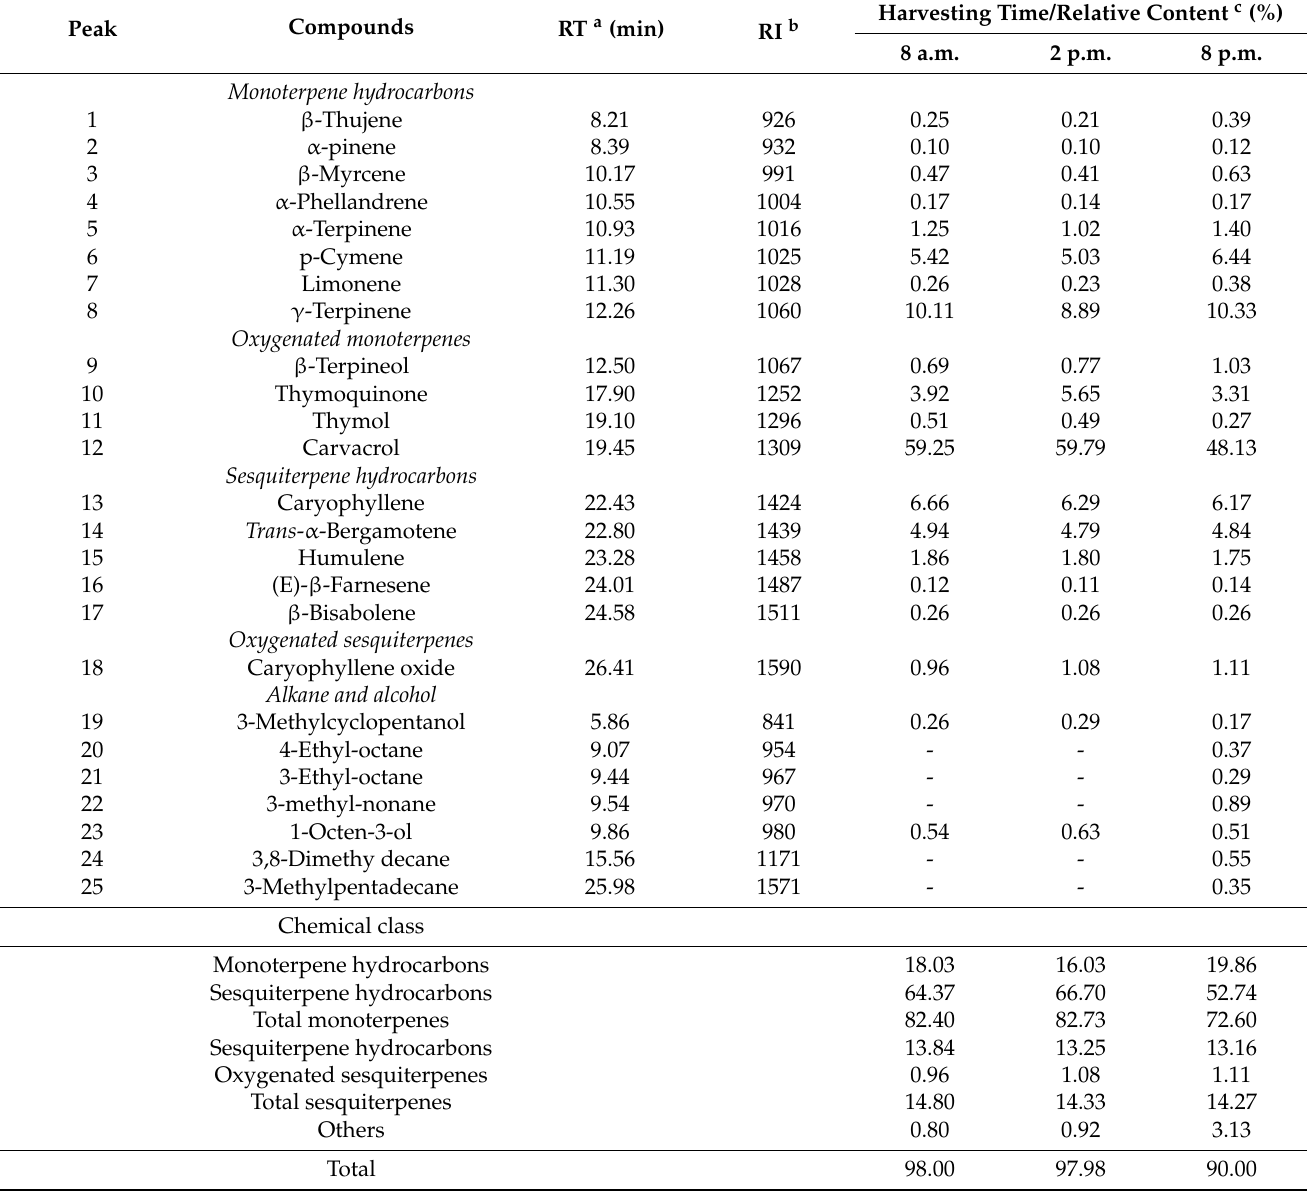
Table 1. Compounds identified from Plectranthus amboinicus leaf essential oil